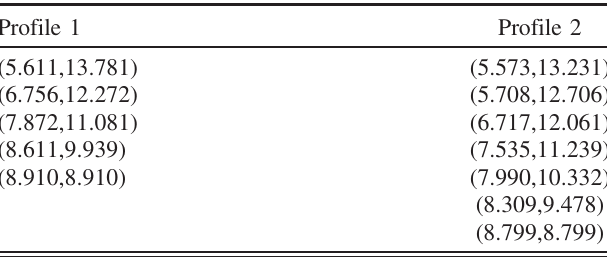
TABLE IV. Coordinates ( X profiles.